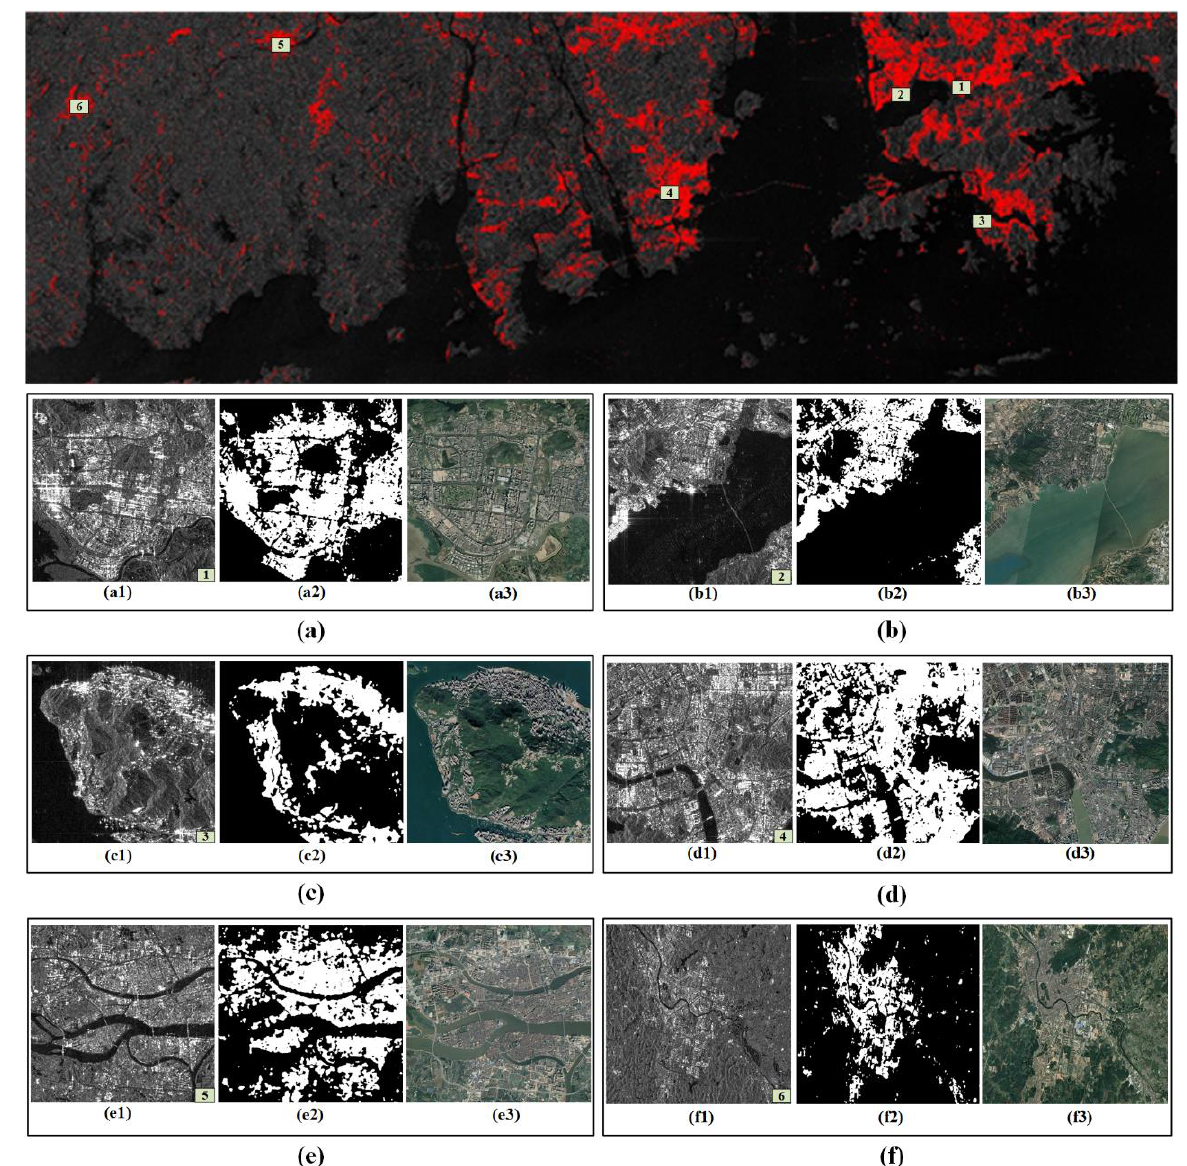
Figure 9. BAs extraction results of our proposed method for the first Sentinel-1 SAR image. The first row denotes the BAs extraction results of the whole SAR image, which are shown in red. ( a – f ) BAs extraction results of six selected regions in the large SAR image, respectively. The left, middle, and right images in ( a – f ) denote the original SAR image, the binary BAs extraction map and the corresponding optical image from Google Earth.